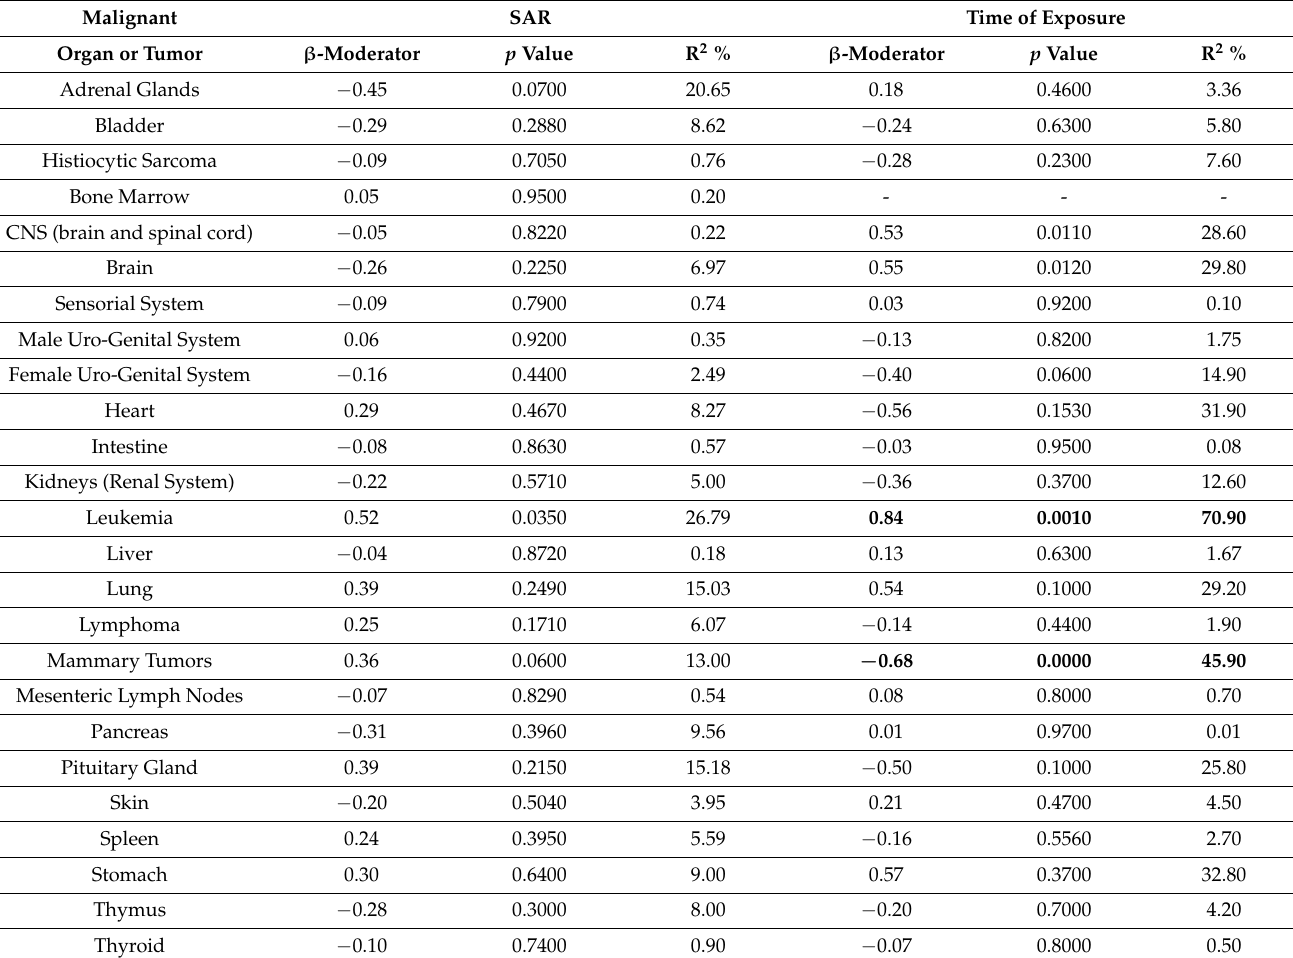
Table 8. Summary table of linear regression analysis for malignant tumors: the selected covariates are the dose (wbSAR) and the overall exposure time. Bold items represent the results with statistical